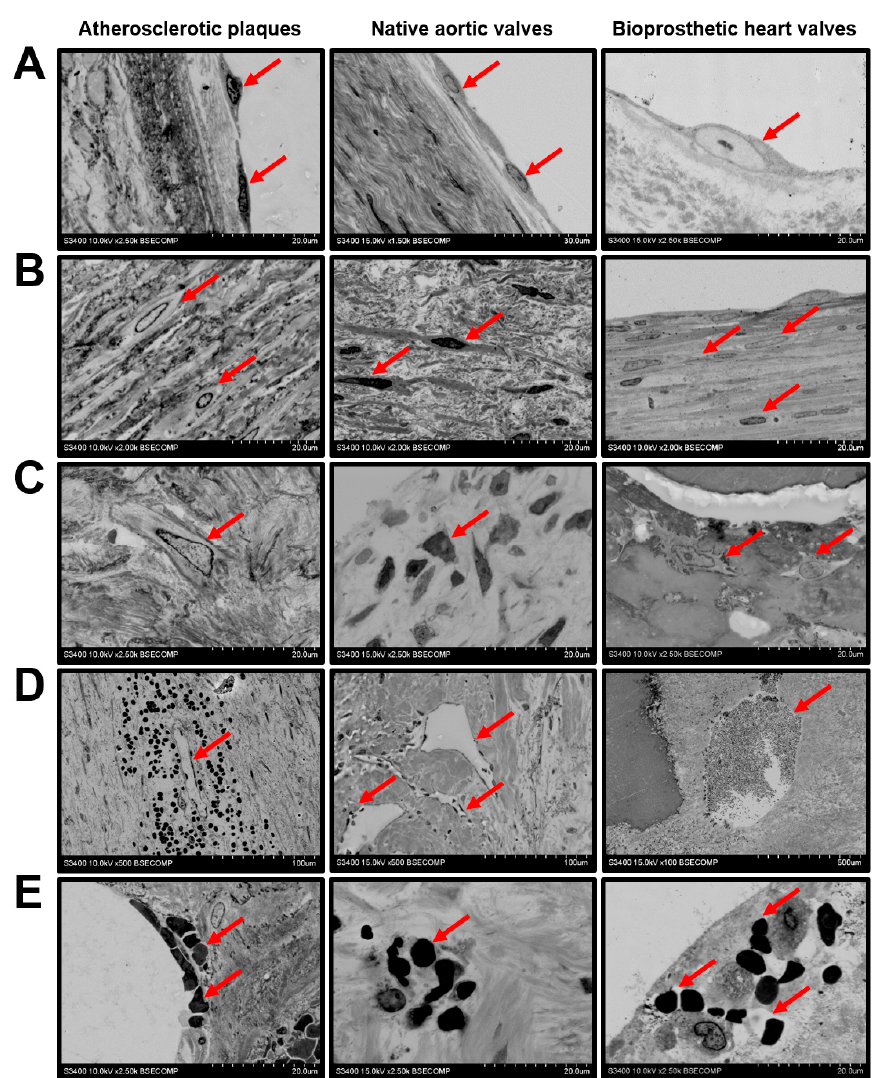
Figure 4. Cellular composition of the atherosclerotic plaques, calcified native AVs, and failed BHVs. ( A ) Endothelial and endothelial-like cells (indicated by red arrows), magnification 1500×–2500×. Note